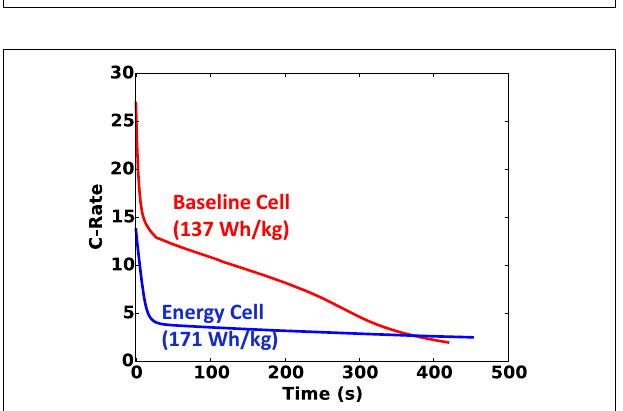
FIGURE 7 | Generalized safety design map for cell with fixed footprint (small A foil ), indicating safety hazard of cells of different capacity (thickness) penetrated with nails of different diameter . Both baseline (red) and alternative energy (blue) cells shown.